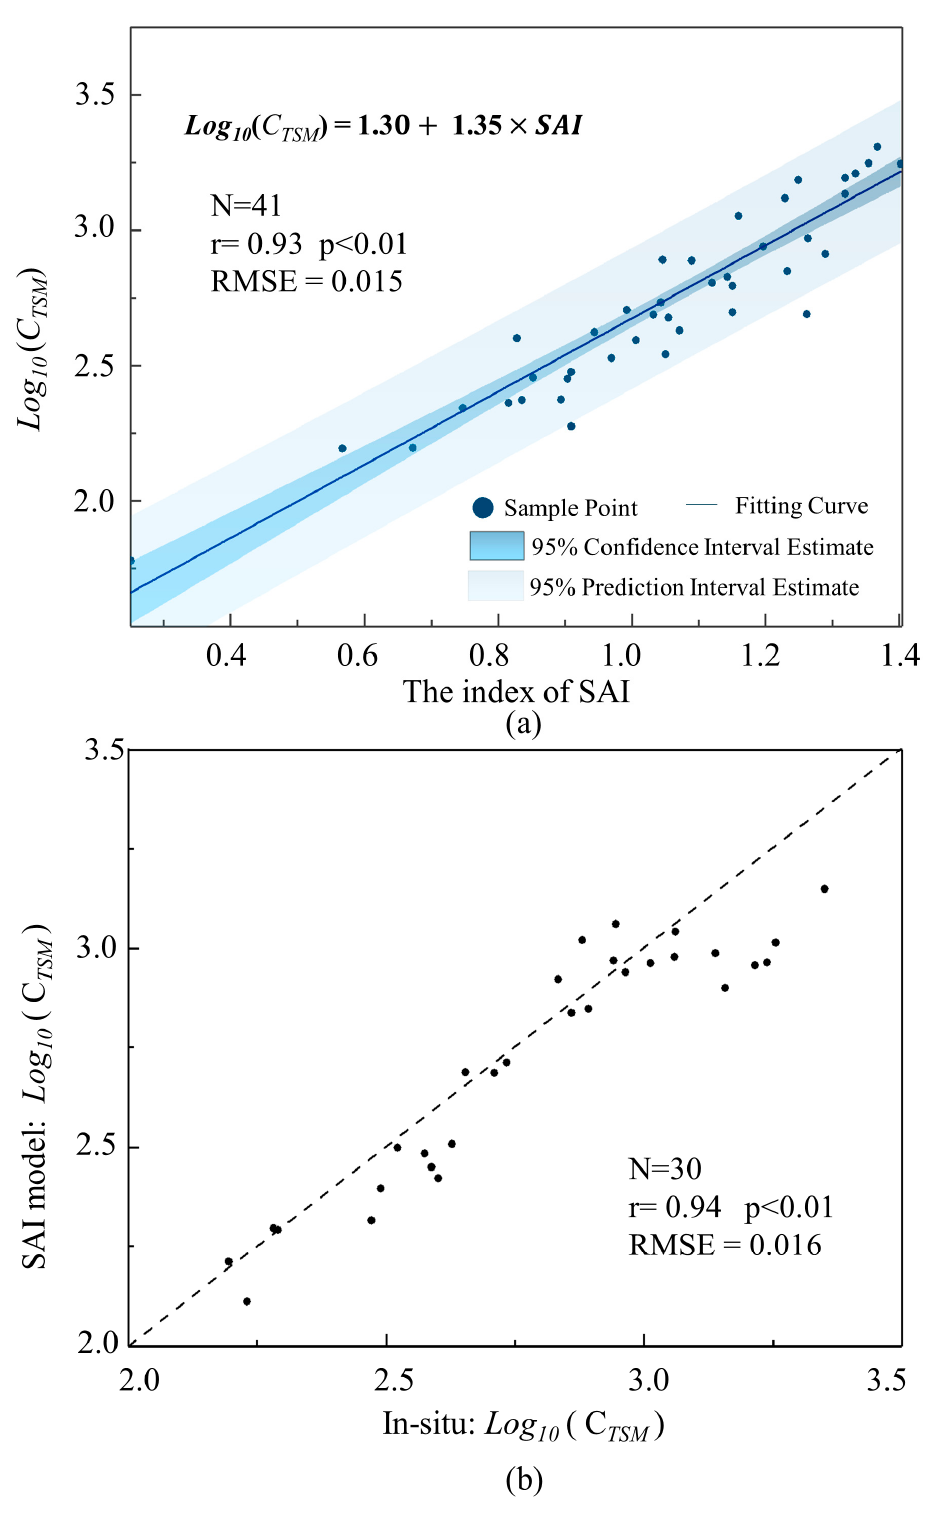
Figure 3. ( a ) The linear regression between the in-situ TSM concentration on the logarithmic scale and the index of the spectral absorption index (SAI). The confidence interval estimation is the estimation interval of the mean value of the dependent variable Log 10 ( C TSM ), and the prediction interval estimate is the estimation interval of a single value of the dependent variable Log 10 ( C TSM ). ( b ) The result of model validation. The X axis represents Log 10 ( C TSM ) of in-situ sample points, and the Y axis represents Log 10 ( C TSM ) of the SAI model calculation. The black dotted lines show the 1:1